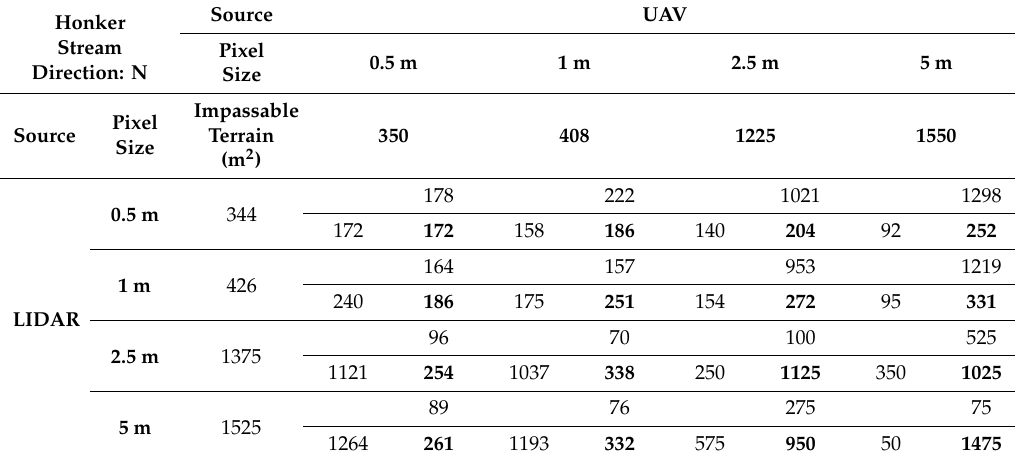
Table 9. Intersection between impassable areas of the Honker moving northward in stream terrain (UAV and LIDAR